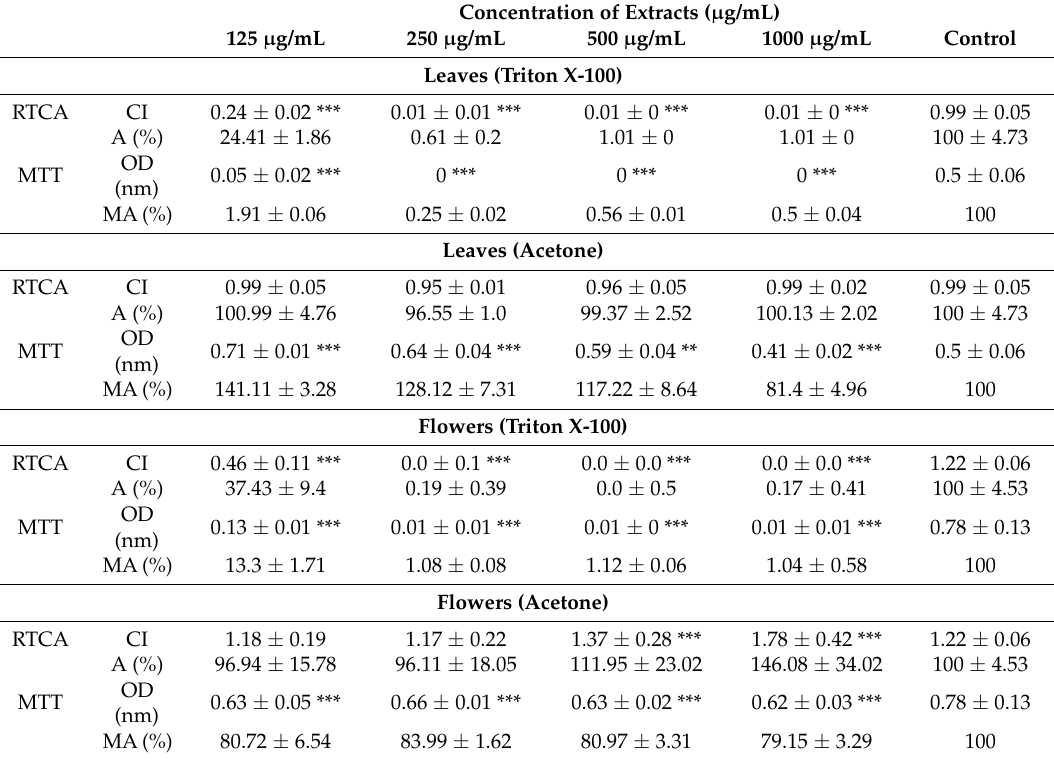
Table 7. The effect of the extracts on the adherence and metabolic activity of the RK13 cells after 48 h exposure. Results are expressed as mean ± SD ( n =